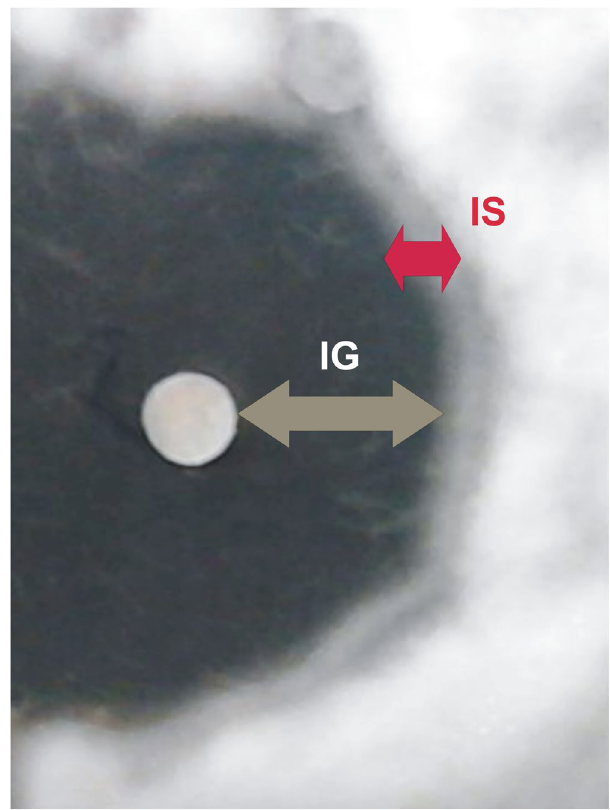
Figure 3. Detailed view of the inhibition of fungal growth and fungal sporulation in Chaetomium globosum after treatment with 5% arborvitae EO dissolved in DMSO. Arrows indicate inhibition of fungal growth (gray arrow IG) and inhibition of fungal sporulation (red arrow IS).